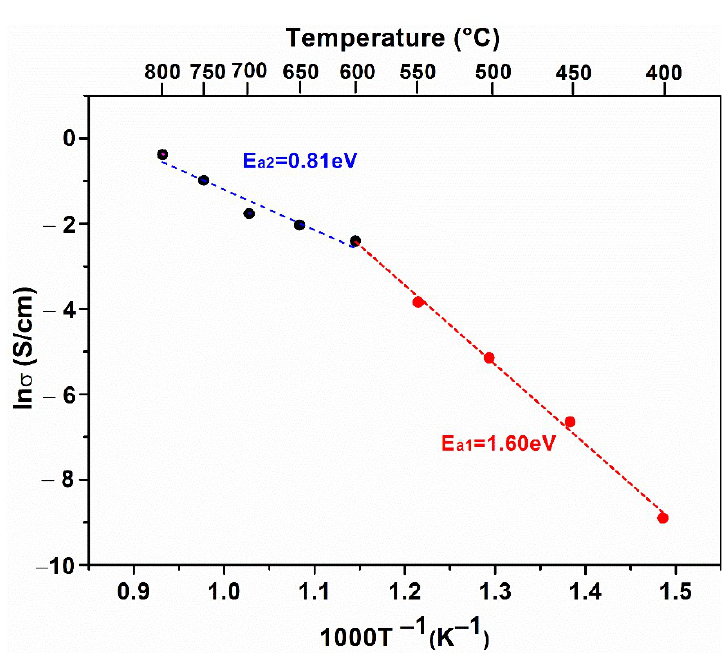
Figure 11. The Arrhenius conductivity plots of Bi 1.5 Y 0.5 O 3 film.